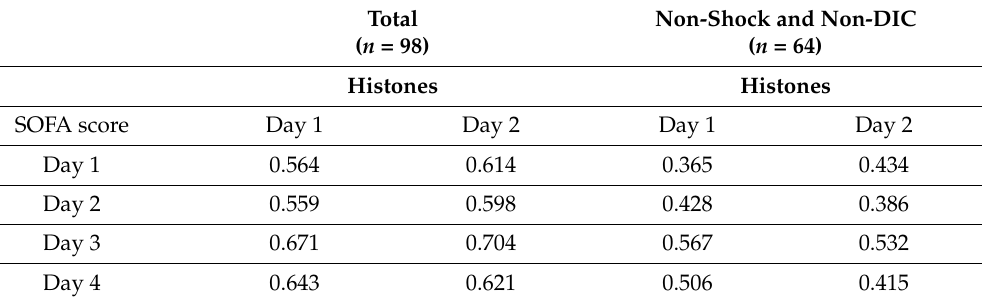
Table 2. Spearmen’s rank correlation coefficient of circulating histones and organ injury scores in critically ill patients.